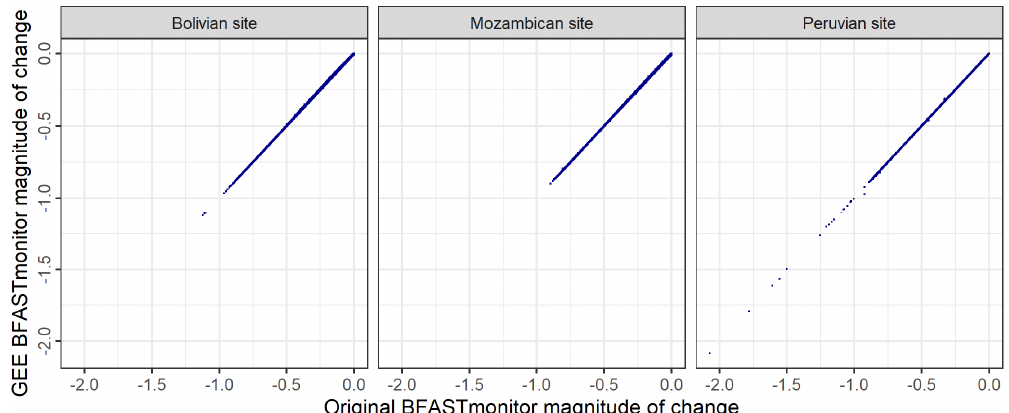
Figure 6. The relationship between the magnitudes of change from BFASTmonitor and GEE BFASTmonitor for forest disturbance detected at Bolivian, Mozambican, and Peruvian sites.